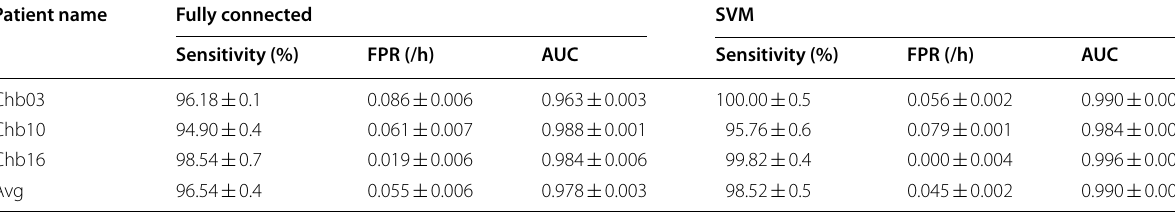
25 min, SPH 5 min) = =